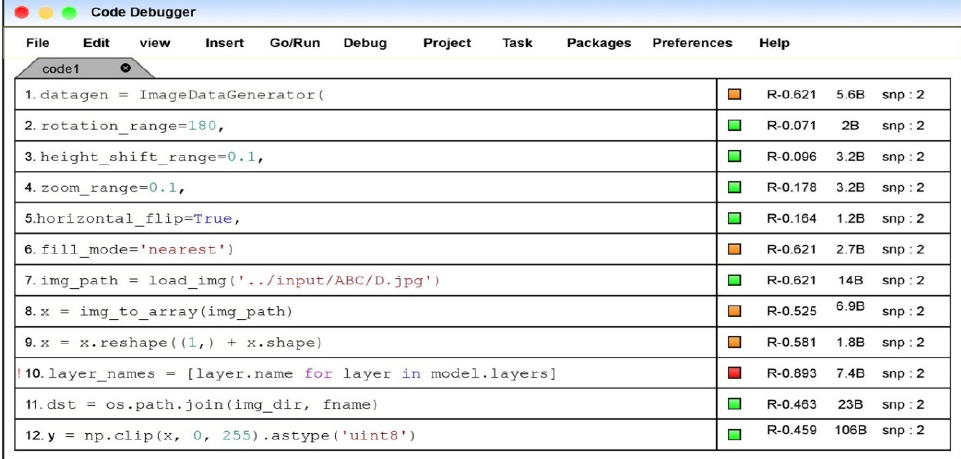
Figure 9. Image of the code editor with fault localization model.